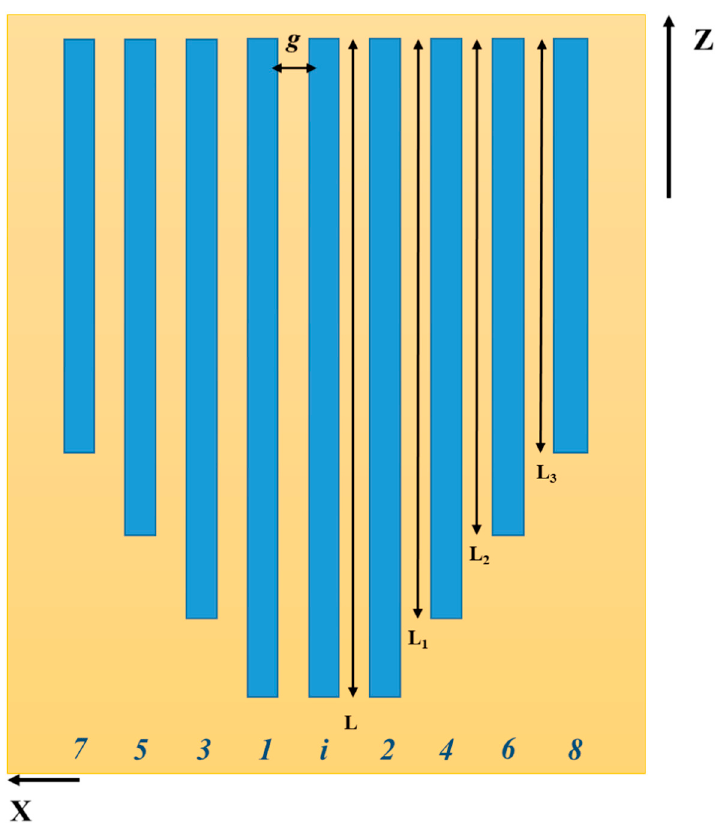
Figure 1. Schematic structure of the proposed eight branch optical power divider in the x-z plane.